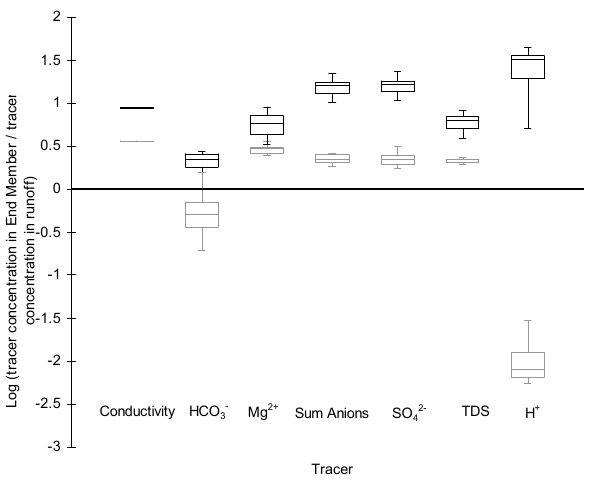
Fig. 2. End member hydrochemical signature as related to tracer selection. Boxplots represent the log of the tracer’s concentration, normalized to its runoff concentration for melt water (dark line) and groundwater (grey line). Relative measures are computed by divid- ing individual values by the average tracer measure in runoff.